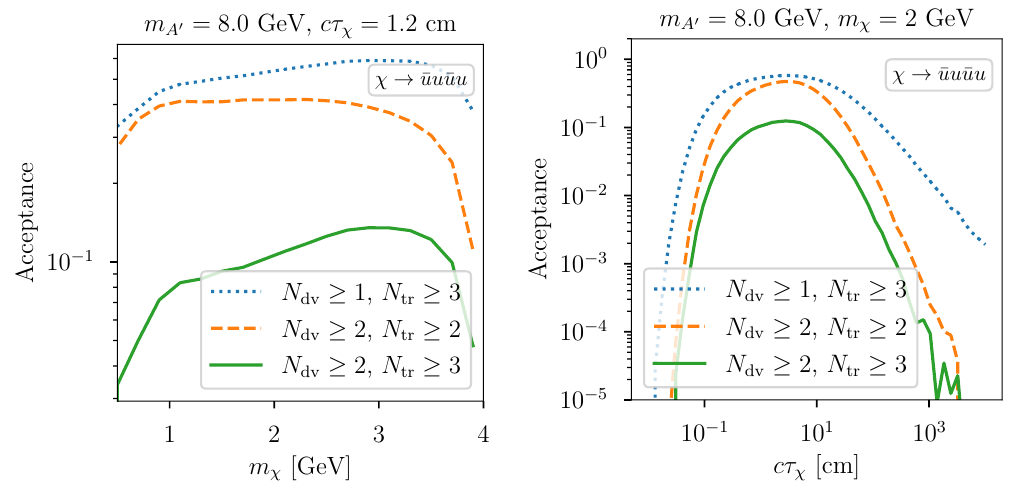
Figure 9 . Slices of the event acceptance probability for LLPs χ decaying to hadrons for dark photon production with m = 8 GeV . The left (right) panel shows the acceptance as a function of A 0 the LLP mass for cτ 1 cm (as a function of cτ for m = 2 GeV ). χ ≈ χ χ